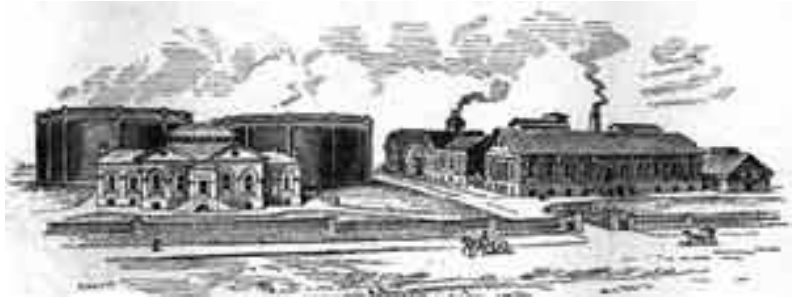
Figure 2. Baltimore’s Bayard Street Station from ―Progressive Magazine‖ of 1889 picturing plant prior to 1850